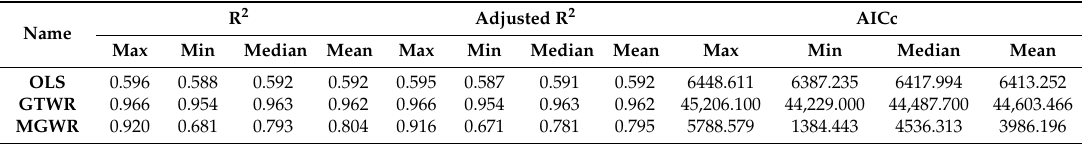
Figure 5. Adjusted R 2 time-serial sliding. Note: Adj.R 2 m represents the adjusted R square after MGWR regression; Adj.R 2 represents the adjusted R square after GTWR regression; Adj.R 2 o represents the adjusted R square after Global regression. Table 3. Summaries of OLS, GTWR and MGWR models.